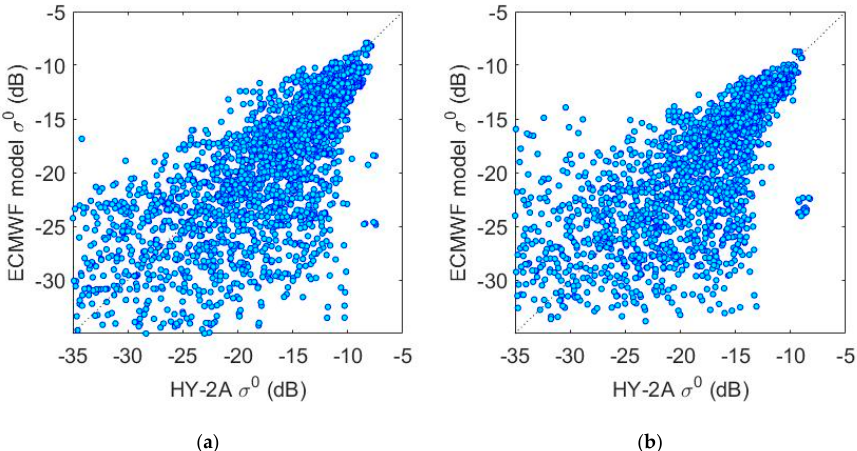
Figure 4. Scatter plot of measure σ 0 and model σ 0 paired data with rainfall. ( a ) for HH polarization; ( b ) for VV polarization. The dashed line in this figure is the diagonal line. Table 3. HY-2A measure σ 0 and ECMWF model σ 0 statistical analysis.